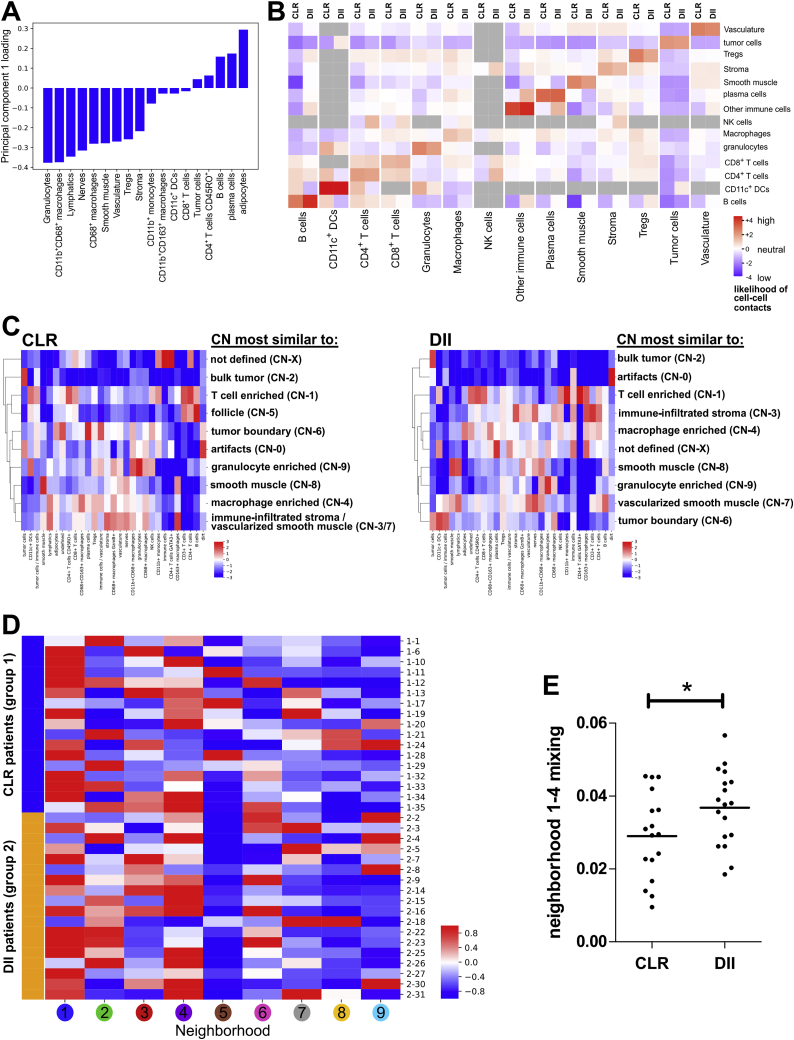
Pairwise Cell-Cell Contacts and CNs in Both Patient Groups, Related to Figure 4(A) PCA correlating combinations of cell-type abundances in CLR versus DII patients. Cell-type loading in principal component 1 is shown. (B) Heatmap of likelihood ratios of direct cell-cell contacts for 14 selected clusters is shown for clusters with at least 100 unique interacting cells. Gray boxes indicate less than 100 unique interacting cells; these data were omitted. Pooled data from all TMA cores are shown. (C) Both CLR and DII patient groups were clustered separately. CNs were annotated manually. CN-0 corresponds to the imaging artifacts cluster; this cluster was omitted from the analysis shown in Figure 4B. Neighborhoods that did not have matching counterparts in the analysis of the combined groups are labeled “not defined.” (D) Frequencies of each CN from Figure 4B in each patient are shown. Frequencies are z scored by column to highlight major differences between CLR patients (blue) and DII patients (orange). (E) The contacts between CN 1 (T cell-enriched) and CN 4 (macrophage-enriched) were computed (see Methods) and are displayed as “CN mixing” by patient group. For each patient, the mean mixing score of four TMA cores is shown (∗p < 0.05, Student’s t test).